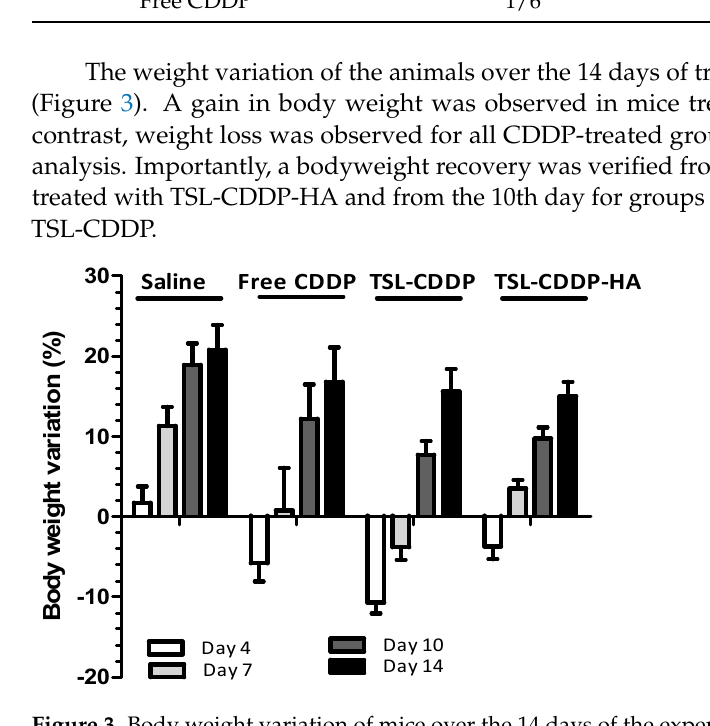
Table 4. Hematological parameters of Swiss mice treated with saline, TSL-CDDP, TSL-CDDP-HA and free CDDP at dose of 10 mg/kg.